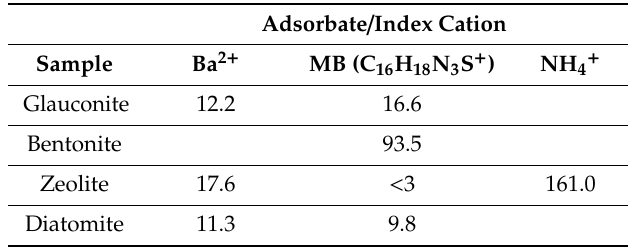
Table 4. Cation exchange capacity of the studied sorbents, meq / 100 g.